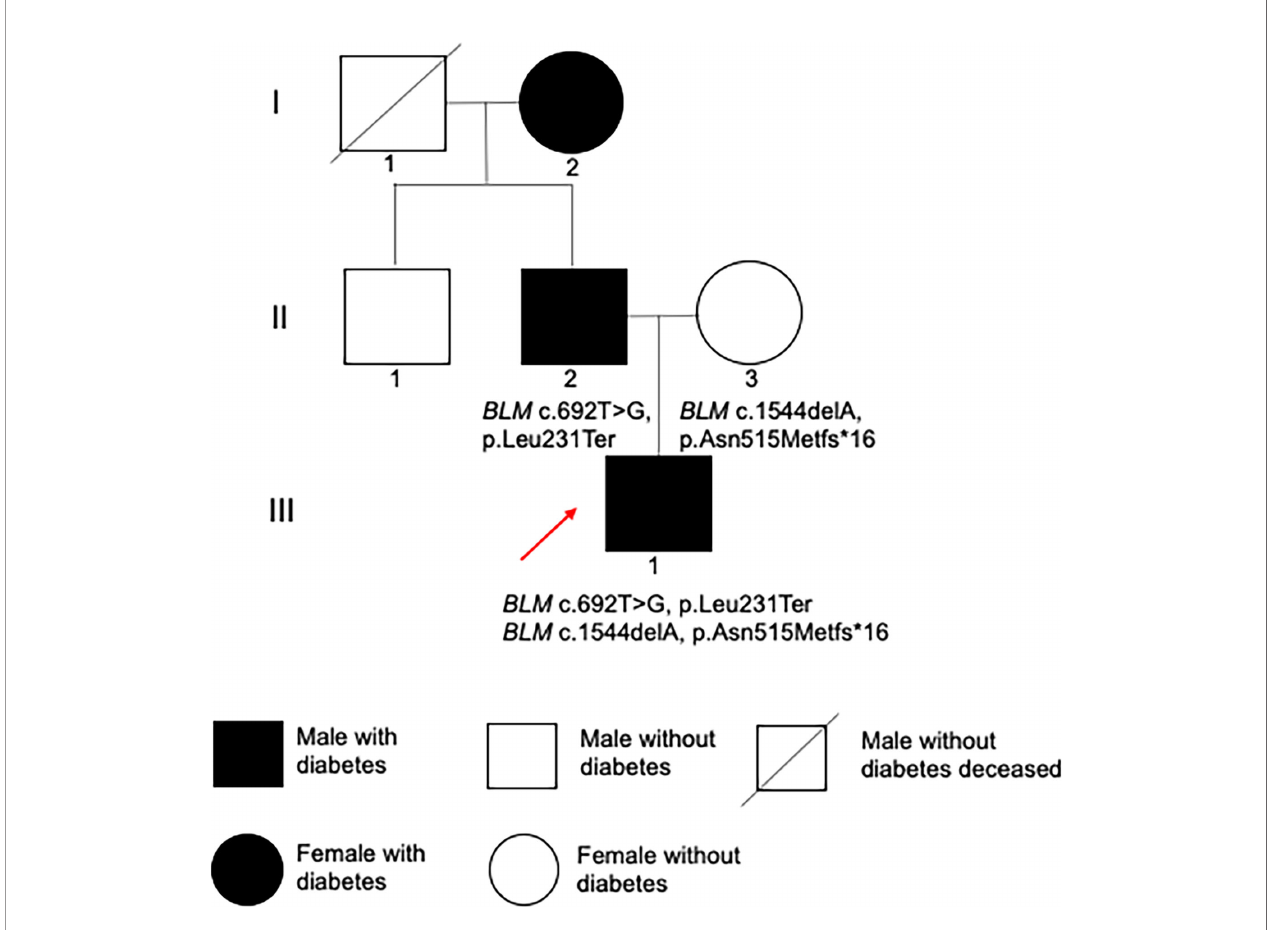
FIGURE 4 | Family pedigree. Filled black symbols represent individuals with diabetes. The red arrow indicates the